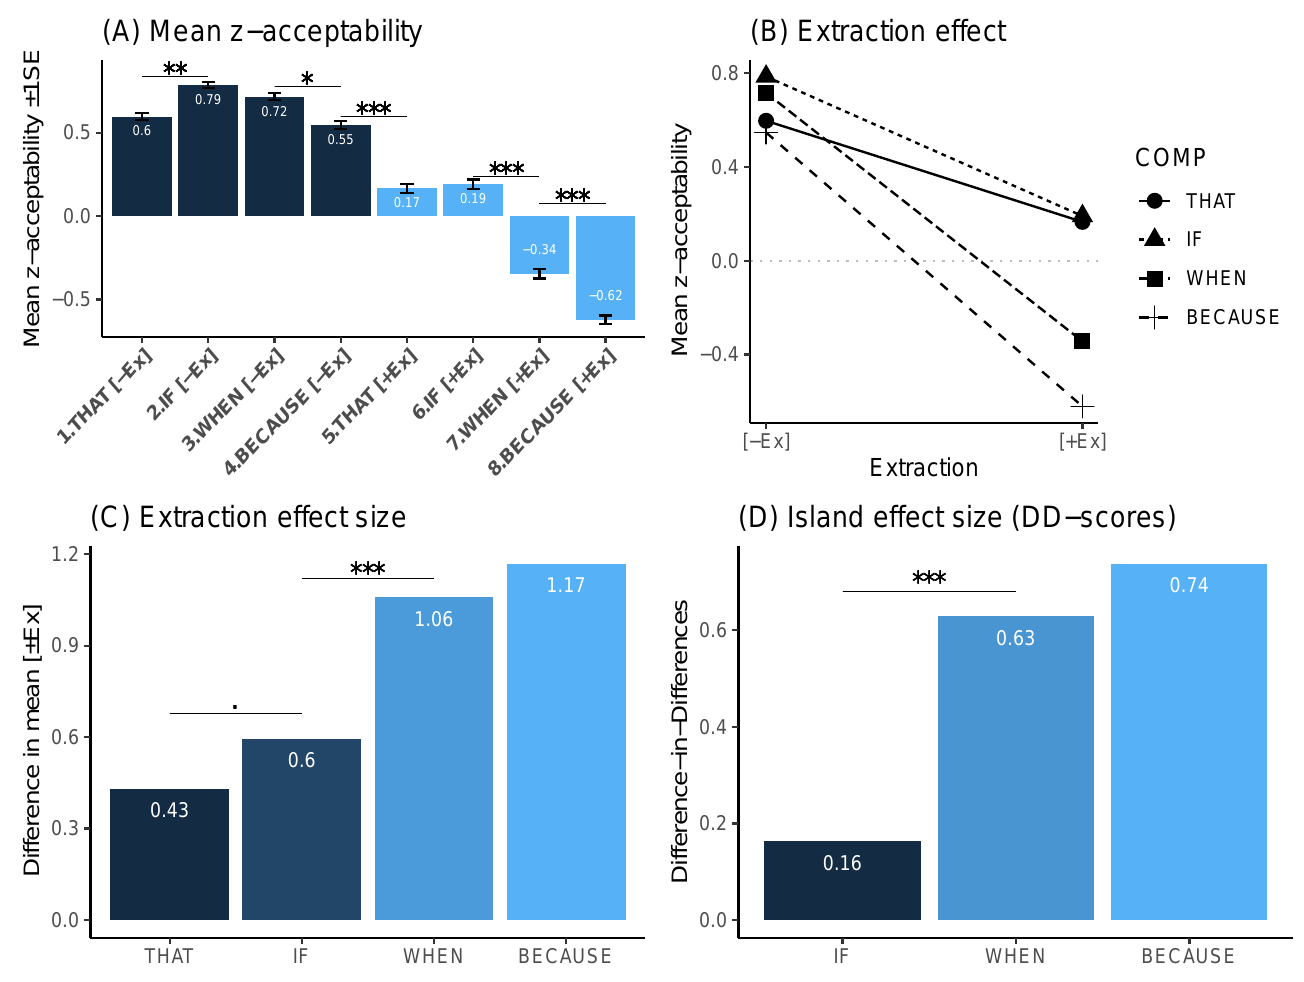
Figure 4. ( A ) Mean z -transformed acceptability ratings. ( B ) Extraction effect. ( C ) Extraction effect size (difference between [+Ex] and [–Ex]). ( D ) Island effect size measured in DD scores (Complementizer x Extraction interaction) between that and the other three complementizers). *** p < 0.001, ** p < 0.01, * p < 0.05, marginal: · p <